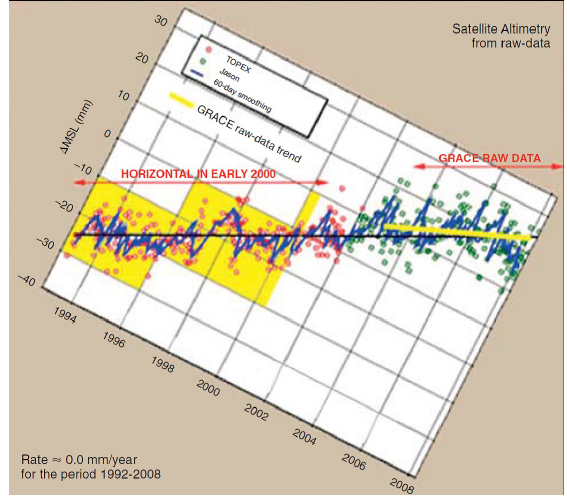
Fig. 5. Raw signal from the Jason/Topex and the GRACE experiments showing as the relative global mean sea level is not increasing over the time window 1993 to 2008. Are the arbitrary corrections that then produce the rising absolute sea level rise of + 3 mm/year. The image is reproduced from